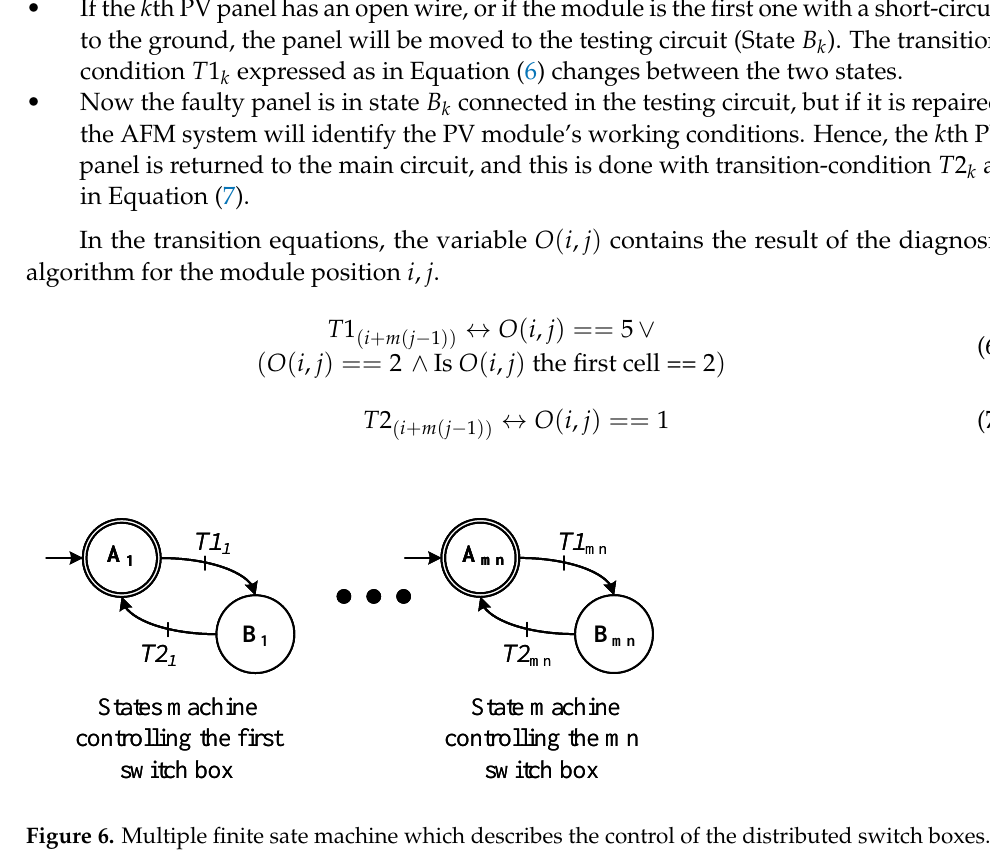
Figure 6. Multiple finite sate machine which describes the control of the distributed switch